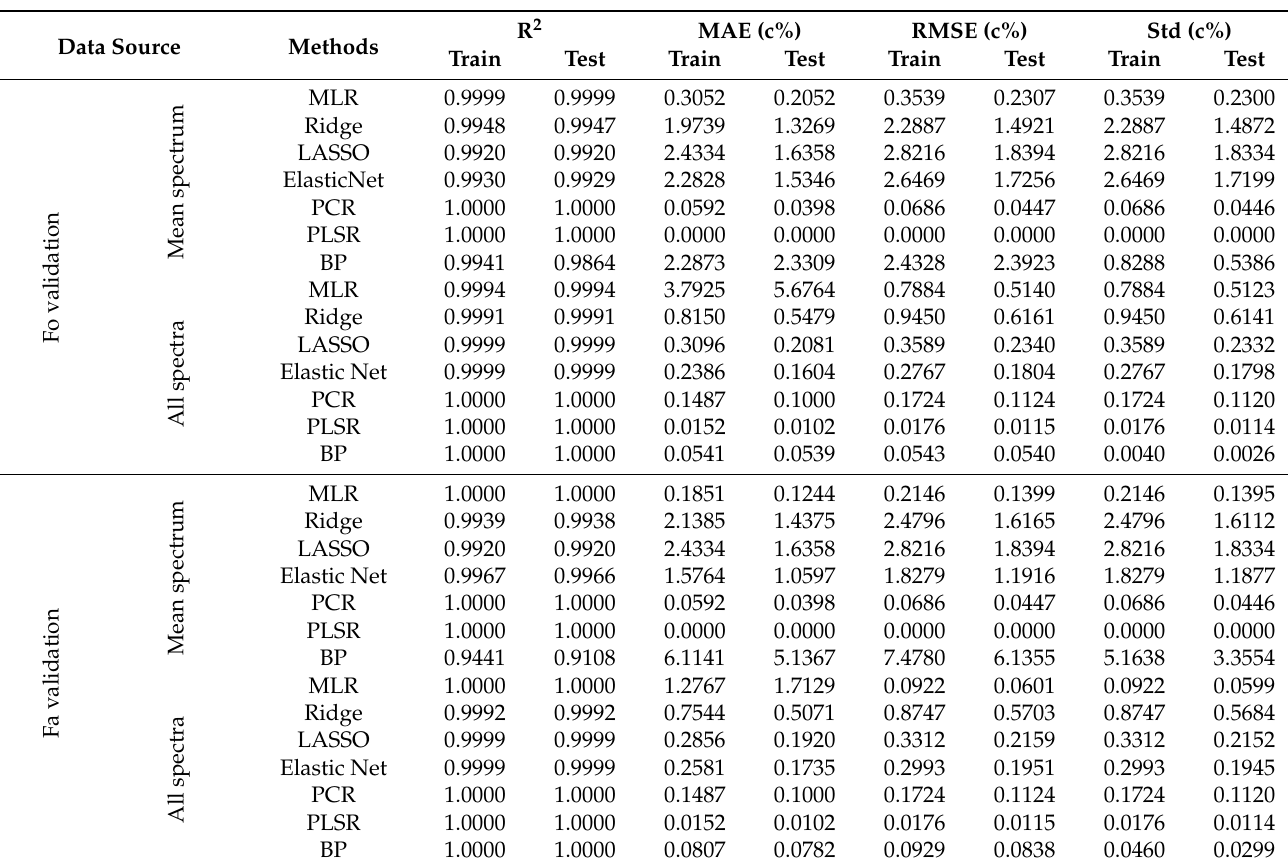
Table 5. Accuracy of validation for Fo and Fa with MLR, ridge, LASSO, elastic net, PCR, PLSR, and BP. Data